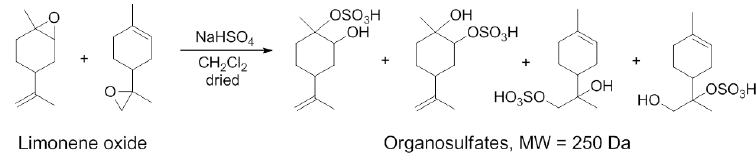
Figure 1. Synthesis of limonene-derived organosulfates with a molecular mass of 250Da (L-OS 250) by ring opening of limonene epoxides with sodium hydrogen sulfate. The reaction is based on Cavdar and Saraçolu (2009).